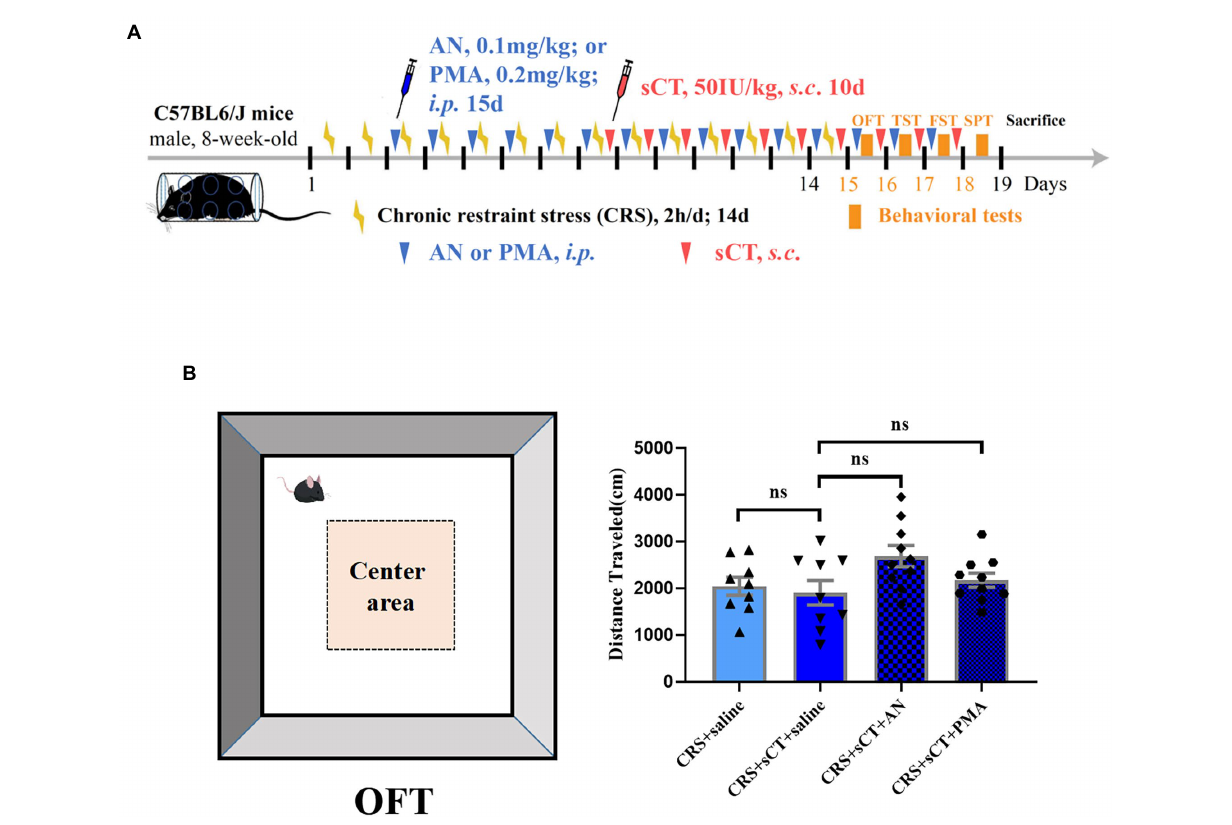
FIGURE 5 Locomotion level did not change in CRS-treated mice after AN or PMA treatment. (A) Timeline of CRS exposure, sCT, AN, PMA administration, and behavioral tests. (B) The distance traveled in OFT did not change in CRS-treated mice after AN or PMA treatment (Depression + saline: n = 9; Depression + sCT + saline: n = 9; Depression + sCT + AN: n = 10; Depression + sCT + PMA: n = 10). The data were analyzed by one-way ANOVA with Tukey’s multiple comparison tests. ns, no